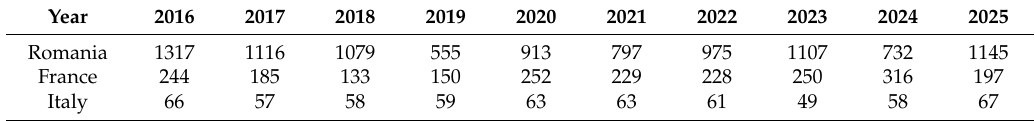
Table 14. Global potential of biodiesel (thousand tons). Source: authors’ own calculation based on [56].